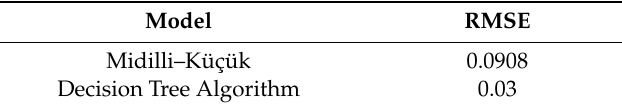
Table 8. Results of